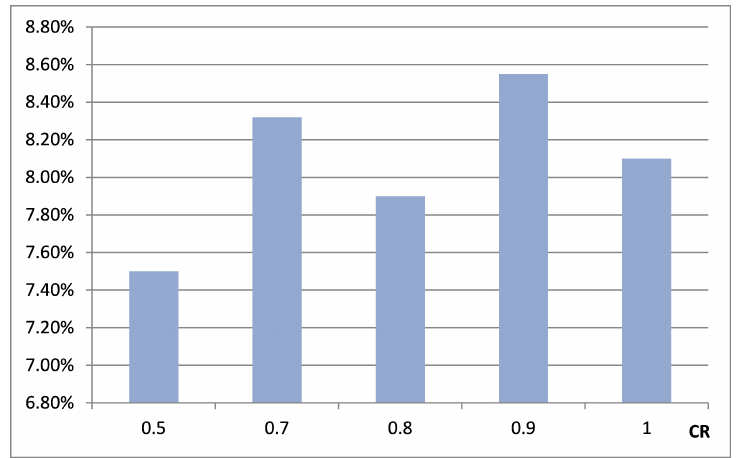
Figure 9. The percentage of time that our proposed algorithm saves compared to the Moreno- Alvarado [2] scheme is under different compression ratios.